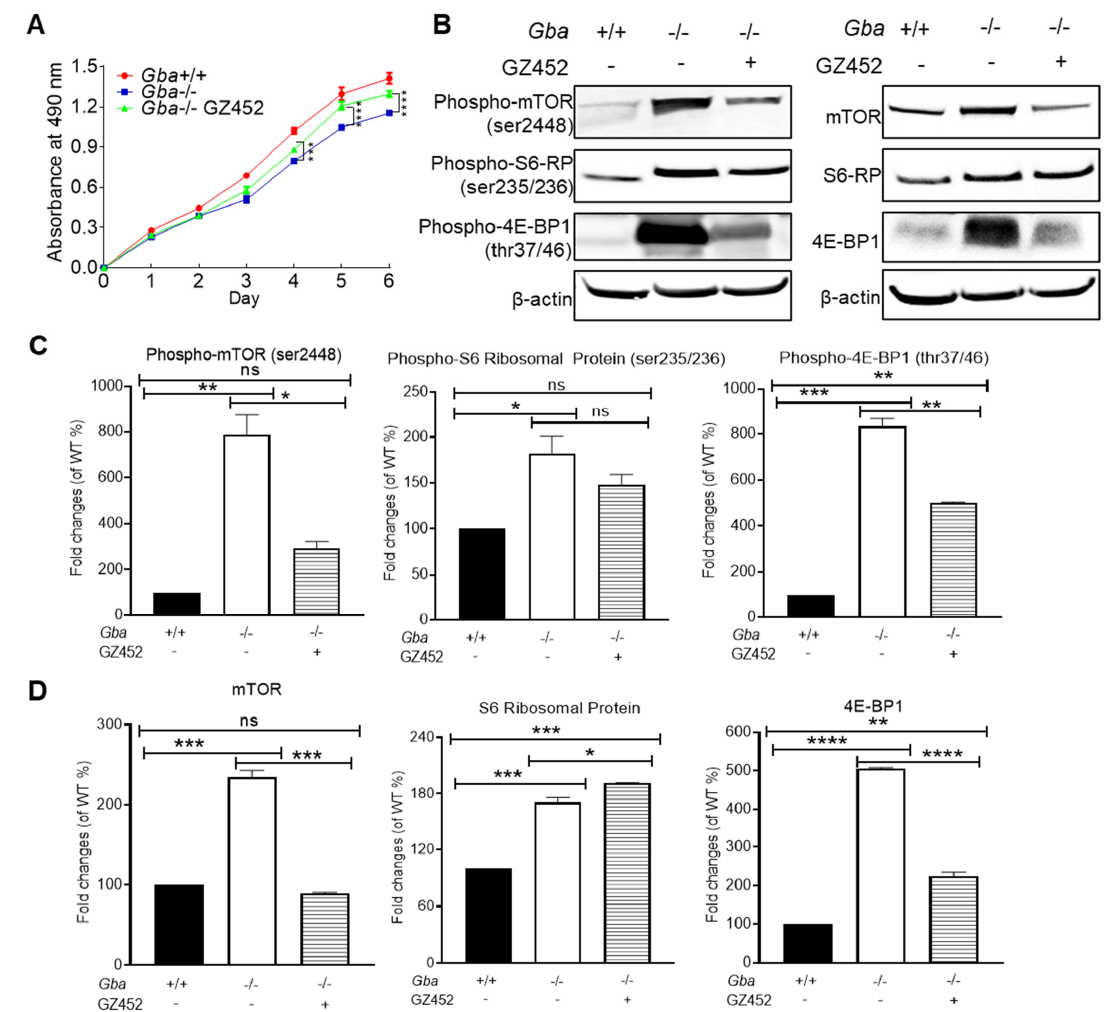
Figure 4. GZ452 treatment improved proliferation and reduced hyperactivity of mTOR pathway proteins in Gba -/- neuron. ( A ) Cell proliferation was measured by MTT assay and presents as absorbance unit at 490 nm (triplicate experiments, n = 8 per experiments). ( B ) Protein levels of phospho-mTOR, phospho-S6 ribosomal protein (S6-RP), phospho-4E-BP1, mTOR, S6-RP, 4E-BP1, and β -actin were measured by WB. ( C ) Quantitation data (normalized by β -actin) of the protein levels of phospho-mTOR, phospho-S6-RP and phospho-4E-BP1. ( D ) Quantitation data of the protein levels of mTOR, S6-RP, and 4E-BP1. Experiments were repeated two or three times ( n = 3 samples). One-way ANOVA analysis (* p < 0.05; ** p < 0.01; *** p < 0.001; **** p < 0.0001). ns, not statistically